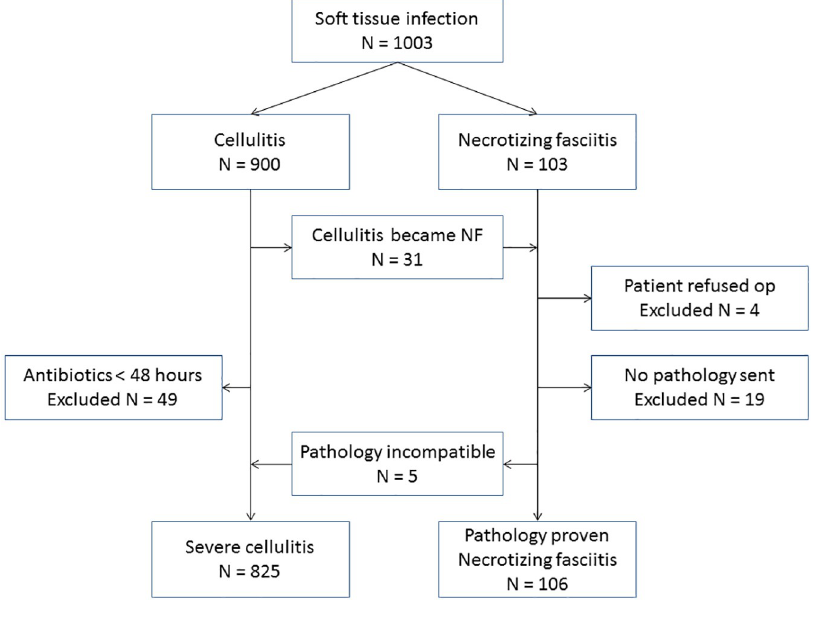
Fig 1. Flow chart of patient